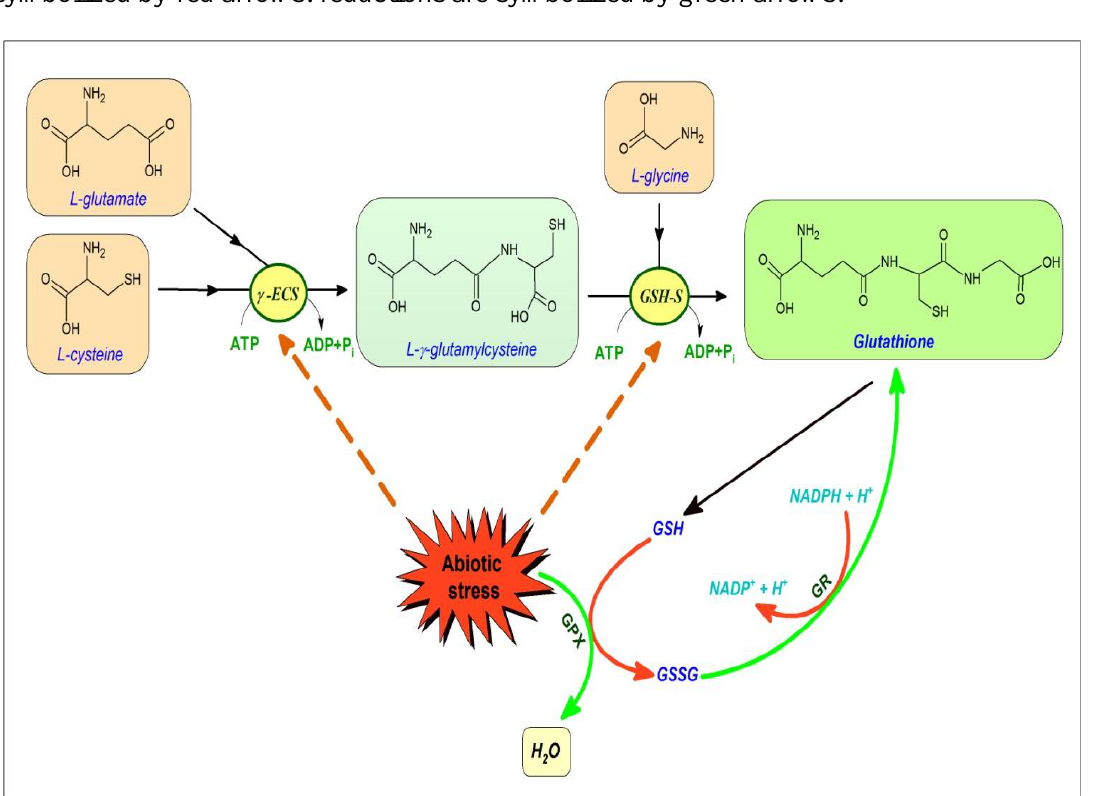
Figure 2. GSH biosynthesis in plants. GSH is synthesized from its constituent amino acids by two ATP-dependent steps. γ-glutamylcysteine ligase (γ-ECS, GSH1) catalyzes the formation of the peptide γ-glutamylcysteine in the second reaction, glutathione synthetase (GSH-S, GSH2) ligates a glycine residue with γ-glutamylcysteine to form GSH. The first step of the biosynthesis has been shown to be a major control point under conditions of increased demand for GSH. The structure  of γ-ECS contains two intramolecular disulfide bridges (CC1, CC2) with strong impact on γ-ECS activity in vitro . Cysteines of CC2 are involved in the monomer-dimer transition, which is probably an important factor in the up-regulation of GSH synthesis in oxidative stress. Plant γ-ECS shows feedback inhibition by GSH. Cadmium or copper treatments induce the transcription of γ-ECS, GSH-S and GR in Arabidopsis. γ-ECS and GSH-S also respond to jasmonic acid, light, drought and certain pathogens. However, neither externally applied H O nor intracellularly generated H O 2 2 2 2 has increased the abundance of γ-ECS or GSH-S transcripts in Arabidopsis. Oxidations are symbolized by red arrows: reductions are symbolized by green